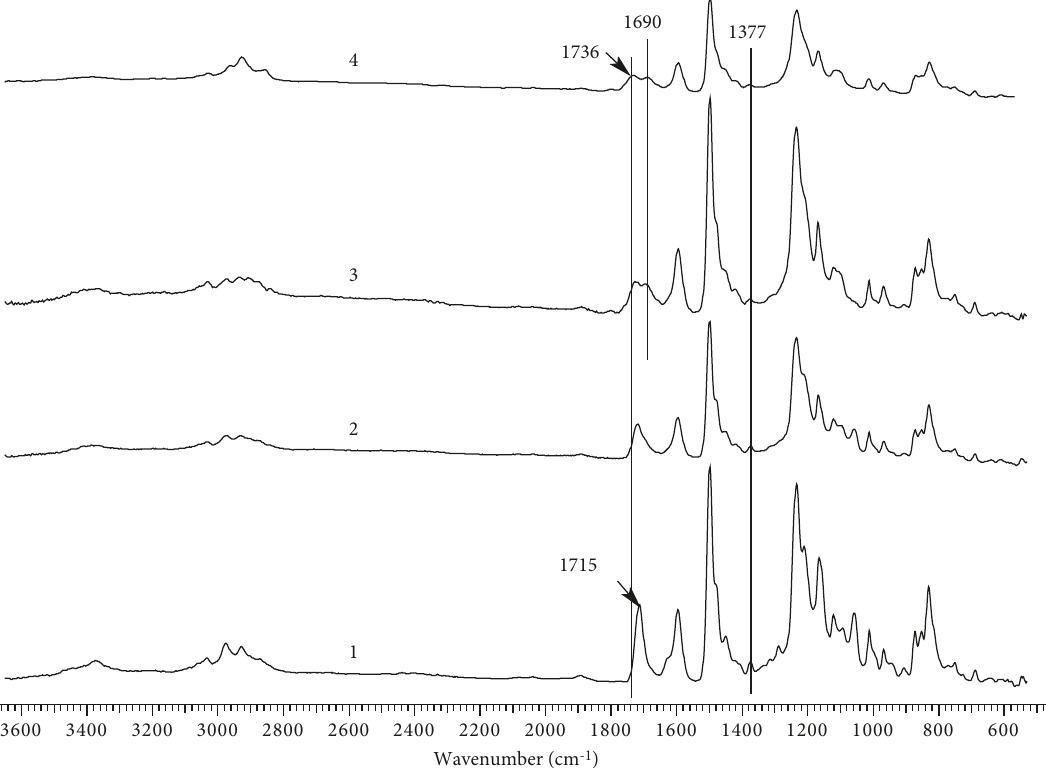
Figure 3: FTIR spectra of the cured ROL-II-1,3-BAPB (V-VIII) blends obtained by heating up to the following fi nal temperatures: 180 ° (1), 220 ° (2), 260 ° (3), and 320 °